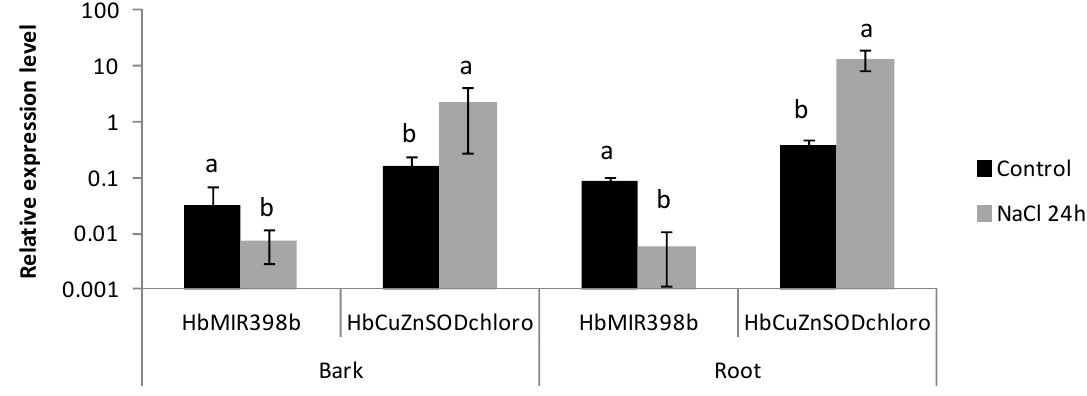
Figure 3. Graph showing the expression values for the chloroplastic HbCuZnSOD and HbMIR398b genes in response to saline stress in bark and roots after 24 h of treatment. The expression values represent the mean and standard deviation of three treated or untreated plants, for each tissue. Data with the same letter are not significantly different at the level of